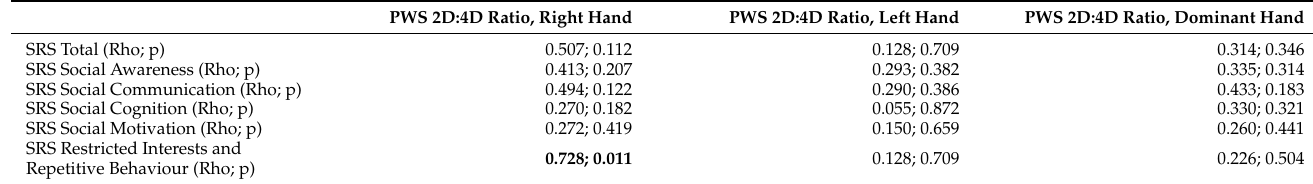
Table 4. Bivariate correlations in male PWS participants (n=11) for 2D:4D ratios. PWS 2D:4D Ratio, Right